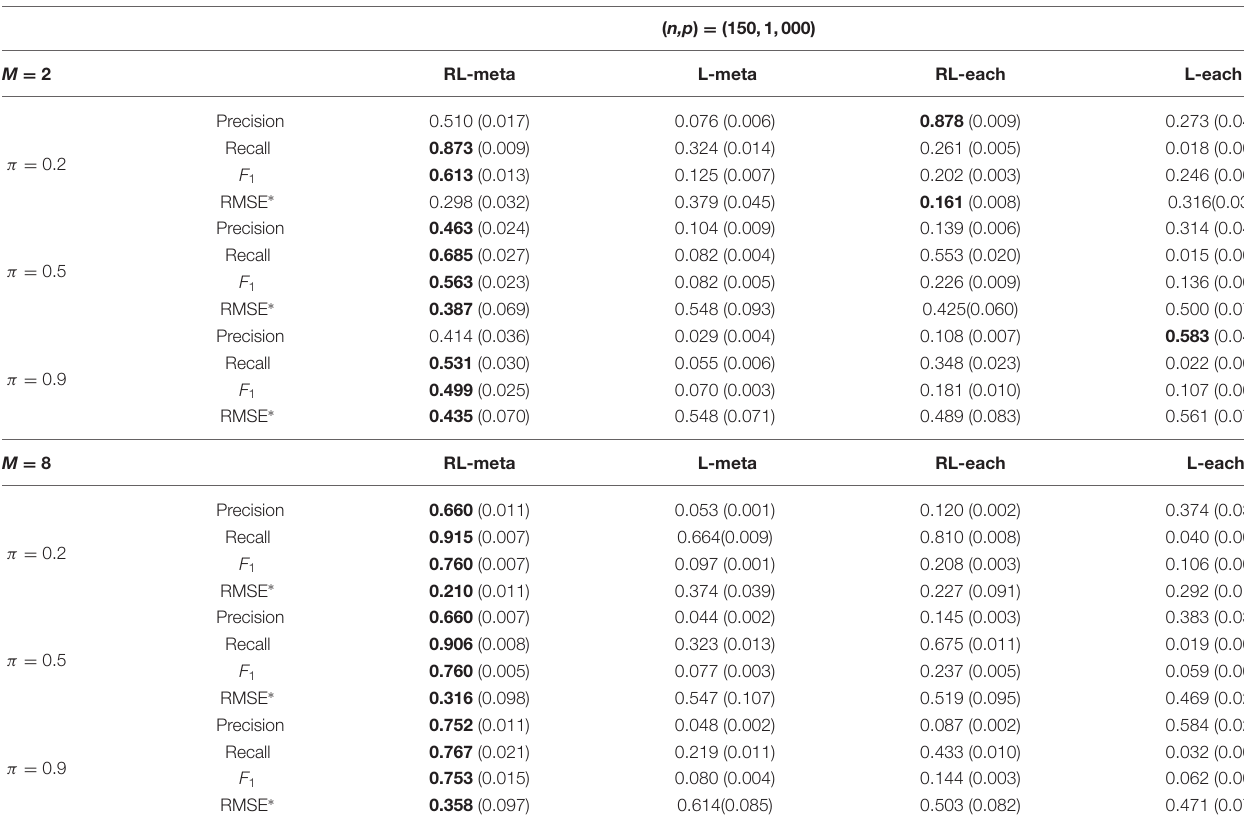
TABLE 4 | Results for high-dimensional data with contamination data.